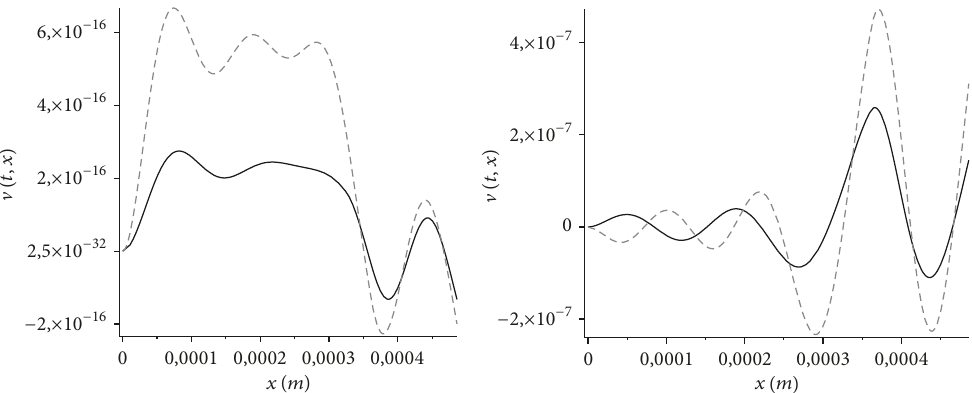
Figure 4: Left: forced response V (𝑡, 𝑥) for 𝑓 1 (𝑡, 𝑥) = V (𝑡)(1 − 𝑢(𝑥 − 𝑙 1 )) . Right: forced response V (𝑡, 𝑥) for 𝑓 1 (𝑡, 𝑥) = V (𝑡)(𝜕 2 𝑀 𝑝 (𝑥)/𝜕𝑥 2 ) . Beam without piezoelectric layer (dashed line) and beam with piezoelectric layer (solid line), V (𝑡) = sin (𝜔𝑡) .